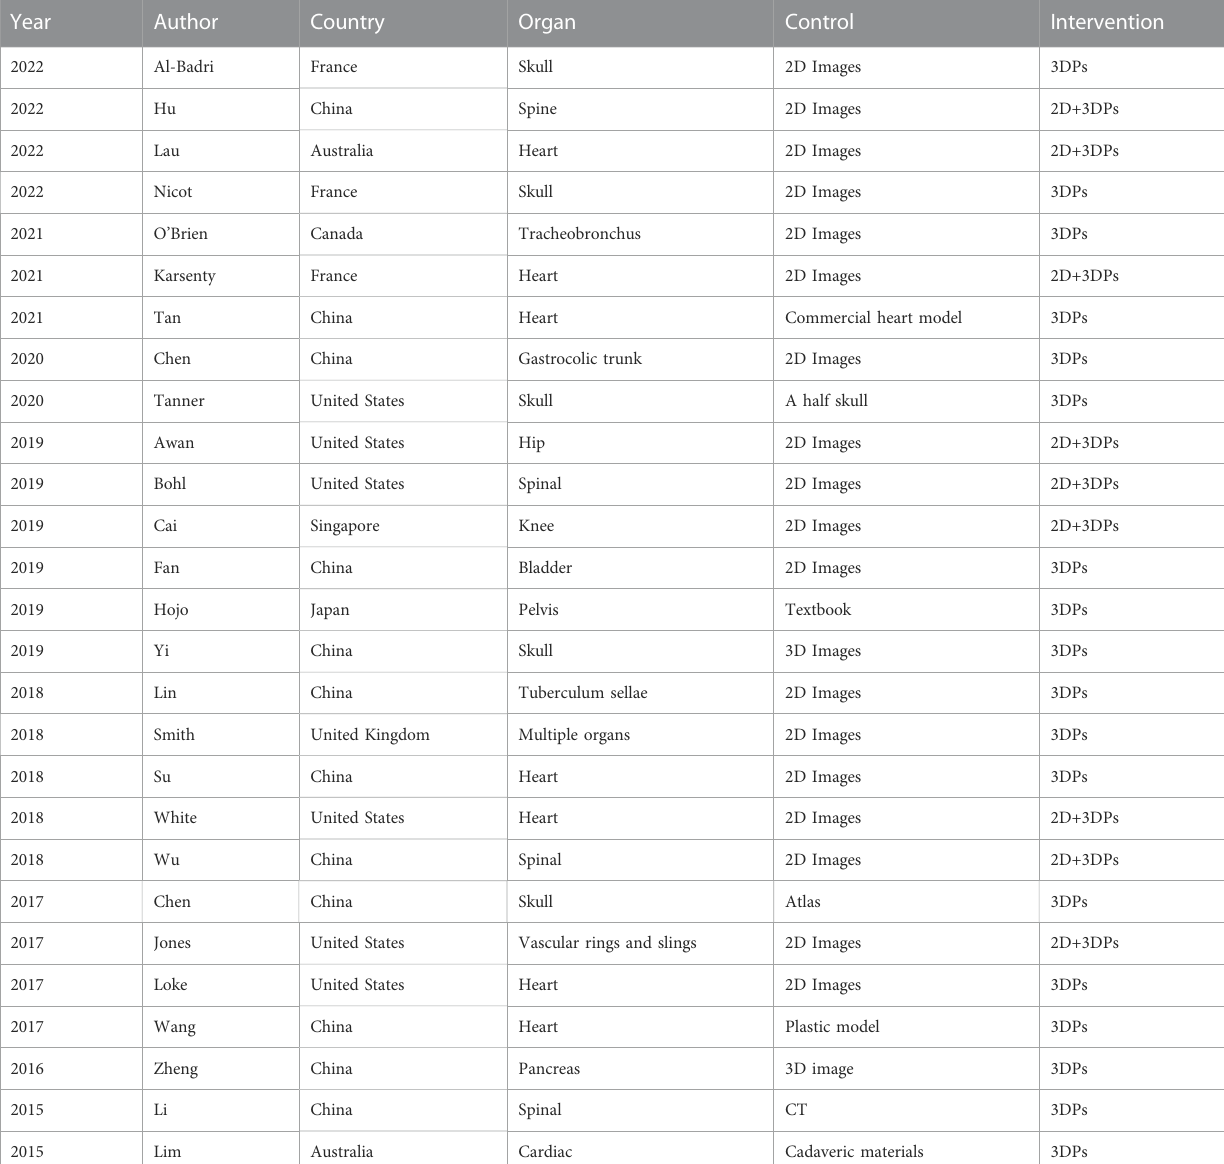
TABLE 1 Basic information of all 27 studies included in the